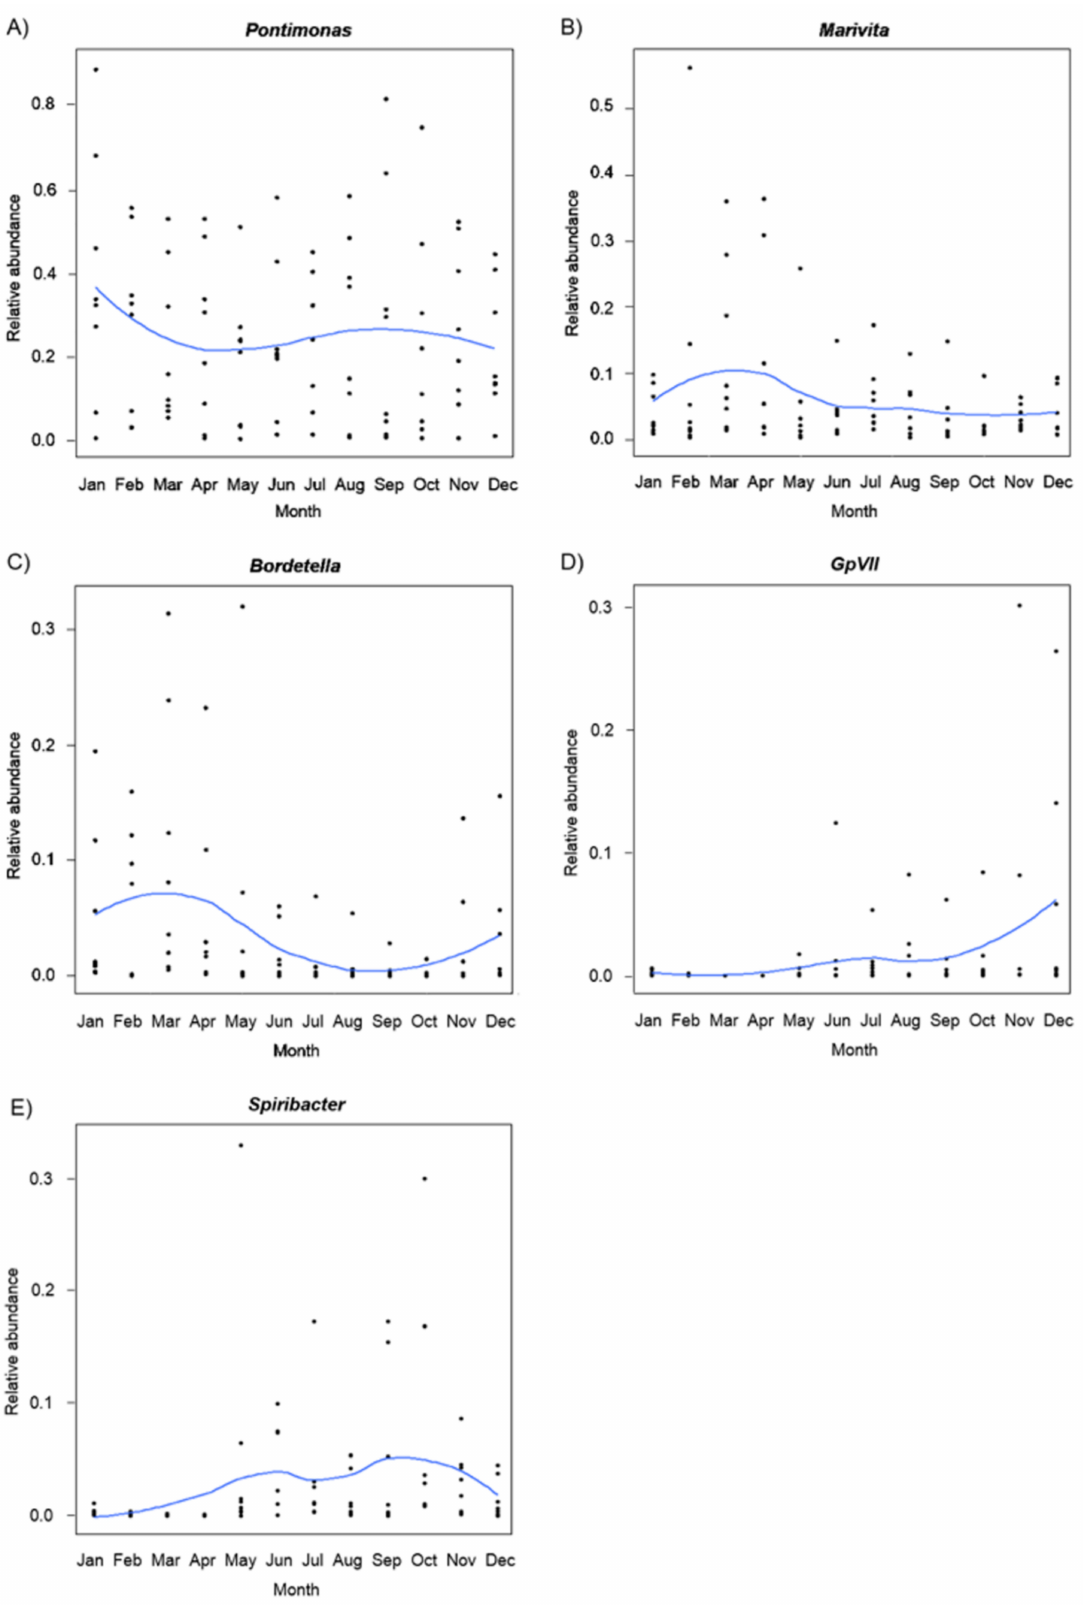
Figure 5. GLM plots showing seasonal variation in abundance of Pontimonas ( A ), Marivita ( B ), Bordetella ( C ), GpVII ( D ) and Spiribacter ( E